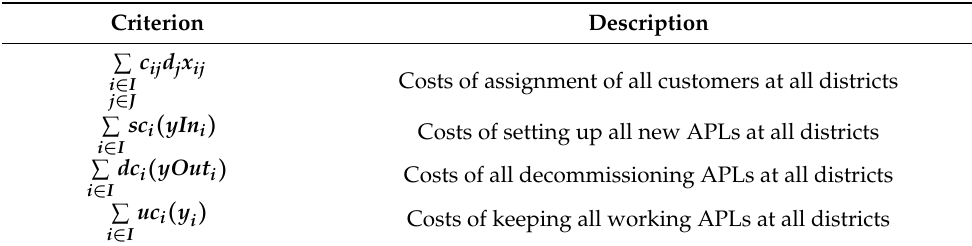
Table 3. Costs criteria included in the multi-objective function.